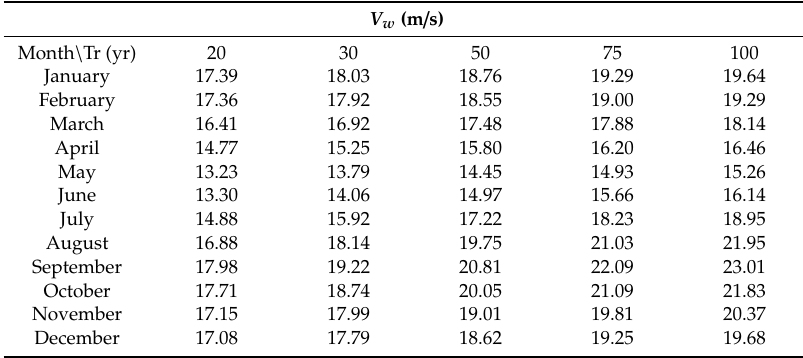
Table A2. Selected return period values for V w in each